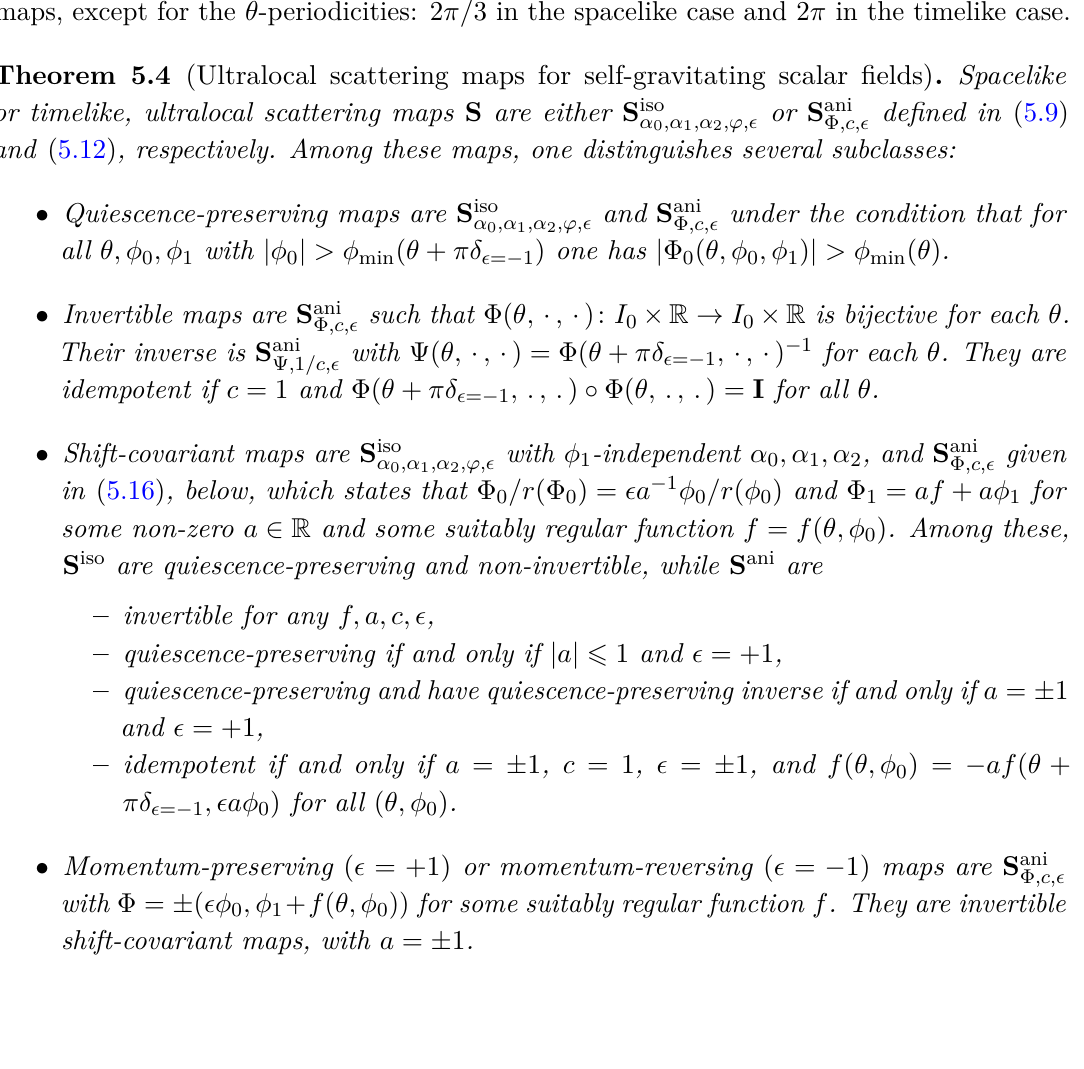
Figure 5 . Kasner disk and triangle. The disk consists of points with r 2 = 1 − 12 πφ 2 (shaded) triangle is characterized by K > 0 or equivalently by | φ 0 | > φ min ( θ ) with φ min defined in